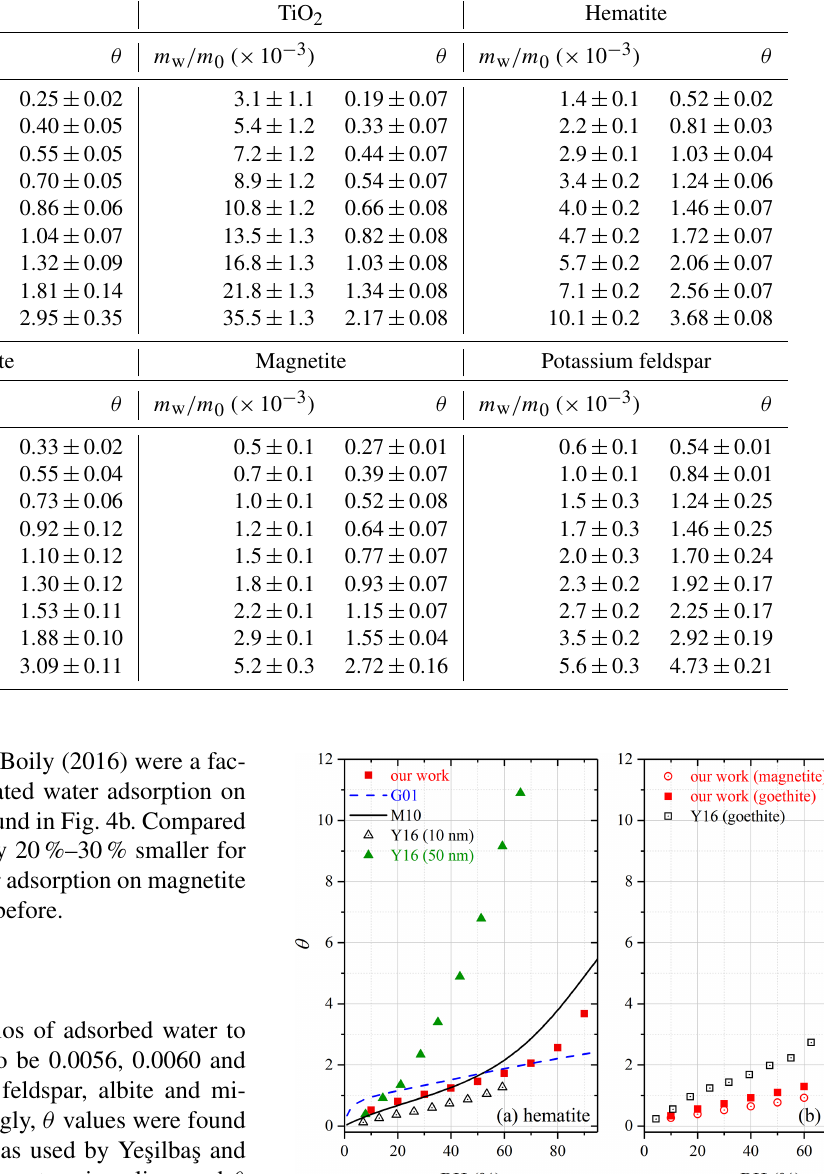
Table 2. Mass ratios of adsorbed water to the dry mineral ( m w /m 0 ) and surface coverages of adsorbed water ( θ ) as a function of RH (%) for SiO 2 , TiO 2 , magnetite, hematite, goethite and potassium feldspar. RH SiO 2 TiO 2 Hematite